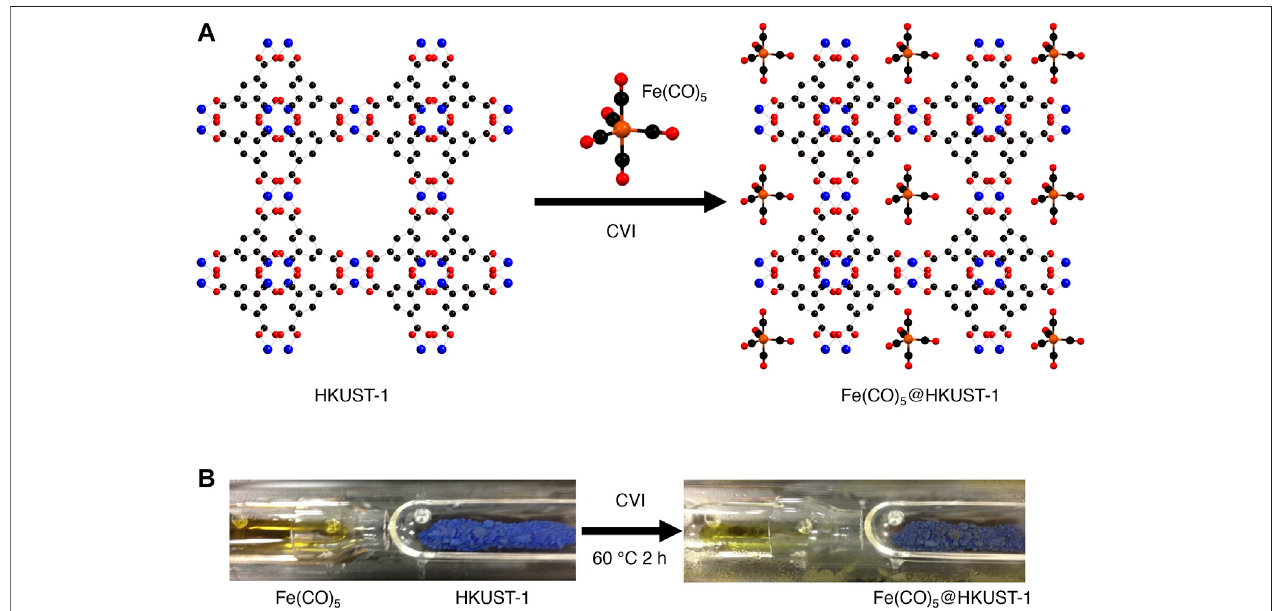
FIGURE 1 | (A) Schematic image and (B) experimental images for Fe(CO) 5 loading in HKUST-1 via a chemical vapor in fi ltration process.